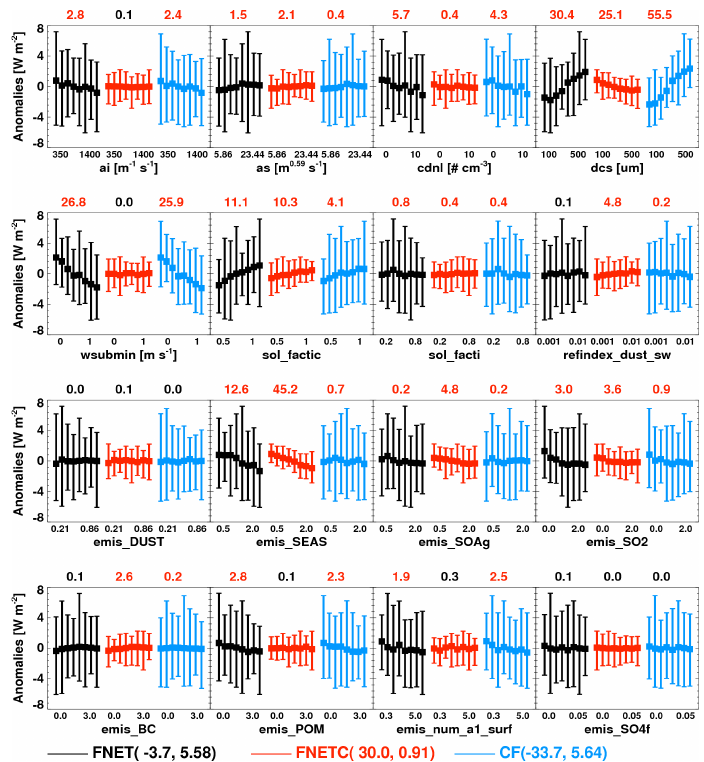
Figure 1 Anomalies of variation of global mean FNET, clear-sky FNET (FNETC), and net (SW + LW) cloud forcing at TOA (CF) in response to the perturbations of 16 parameters from the 256 CAM5 simulations. The 256-simulation mean and variance are shown, respectively, in the parenthesis for FNET, FNETC, and CF. The numbers above each plot box represent the relative contribution (percentage) of each input parameter perturbation to the overall FNET, FNETC, and CF variations. Red means the contribution with 95% statistic significance.